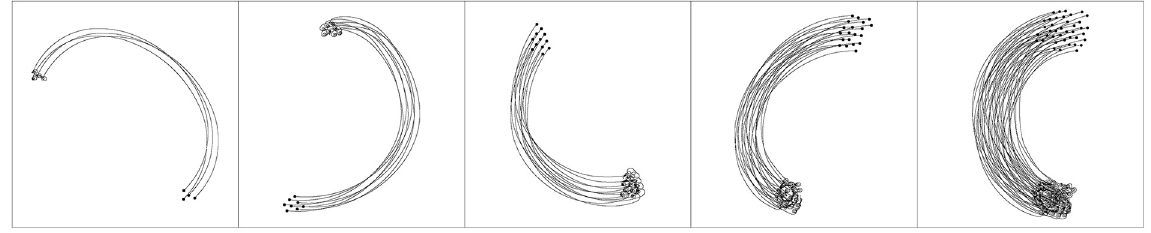
Fig 7. Example of the behaviour displayed in the scalability experiments, with 4, 8, 12, 20 and 40 robots, from left to